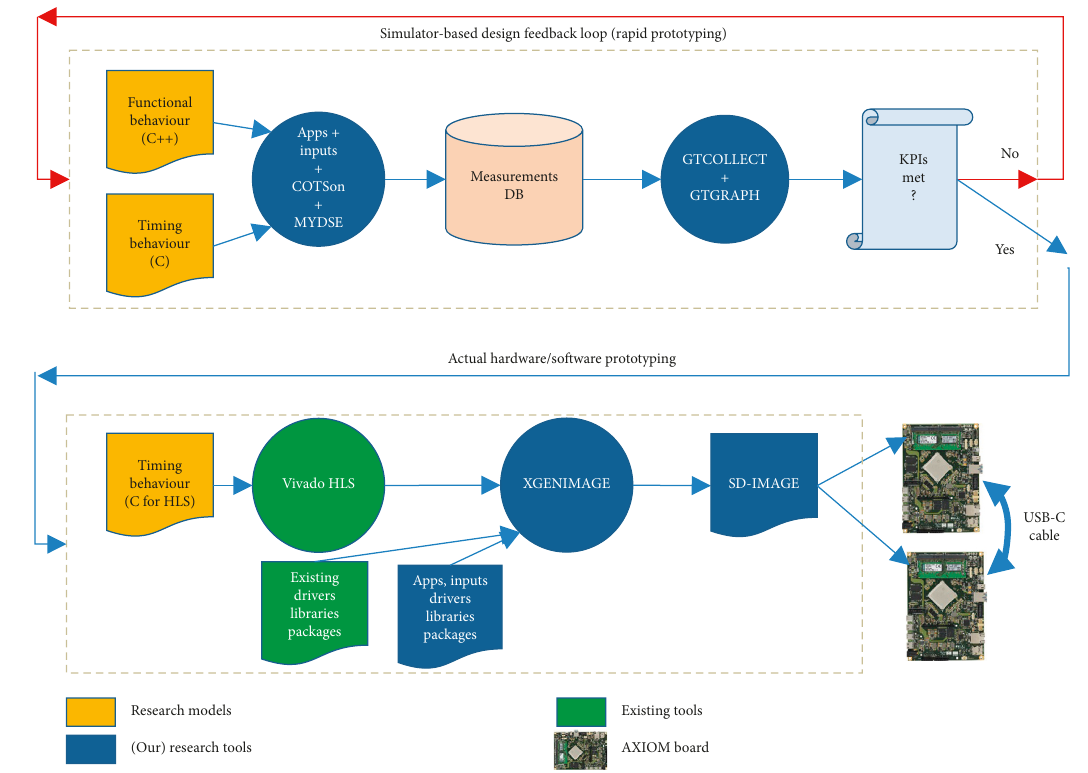
Figure 1: Design and test methodology of the AXIOM involved a mix of simulation (via the COTSon simulator and other custom tools) and FPGA prototyping (via our custom AXIOM board and hardware synthesis tools (like Vivado HLS)) [11].